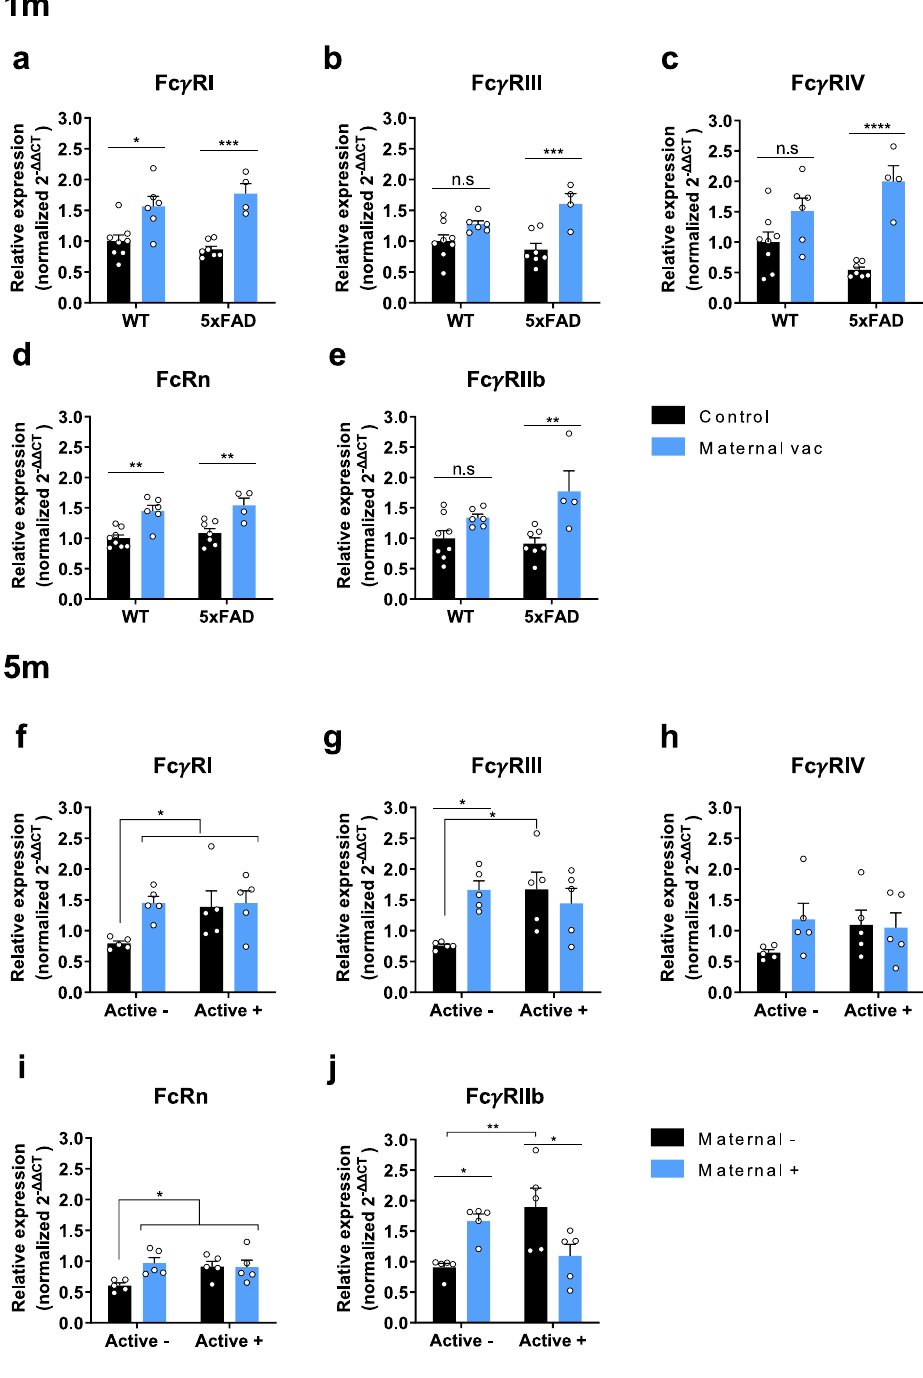
Fig. 5 Maternal vaccination induces long-term FcRs upregulation in the brain. Levels of cerebral FcR mRNA were quanti fi ed using RT-qPCR after maternal vaccination at 1 m of age ( a – e ) and following maternal and active vaccination at 5 m of age ( f – j ). mRNA levels of ( a ) Fc γ RI, ( b ) Fc γ RIII, ( c ) Fc γ RIV, ( d ) FcRn, and ( e ) Fc γ RIIb in 1m-old WT ( n = 14 ) and 5xFAD ( n = 11 ) mice. Levels of ( f ) Fc γ RI, ( g ) Fc γ RIII, ( h ) Fc γ RIV, ( i ) FcRn, and ( j ) Fc γ RIIb in maternally and actively vaccinated 5m-old 5xFAD mice ( n = 5 ). * P < 0.05, ** P < 0.01, *** P < 0.001, **** P < 0.0001, two-way ANOVA, data are presented as mean ±